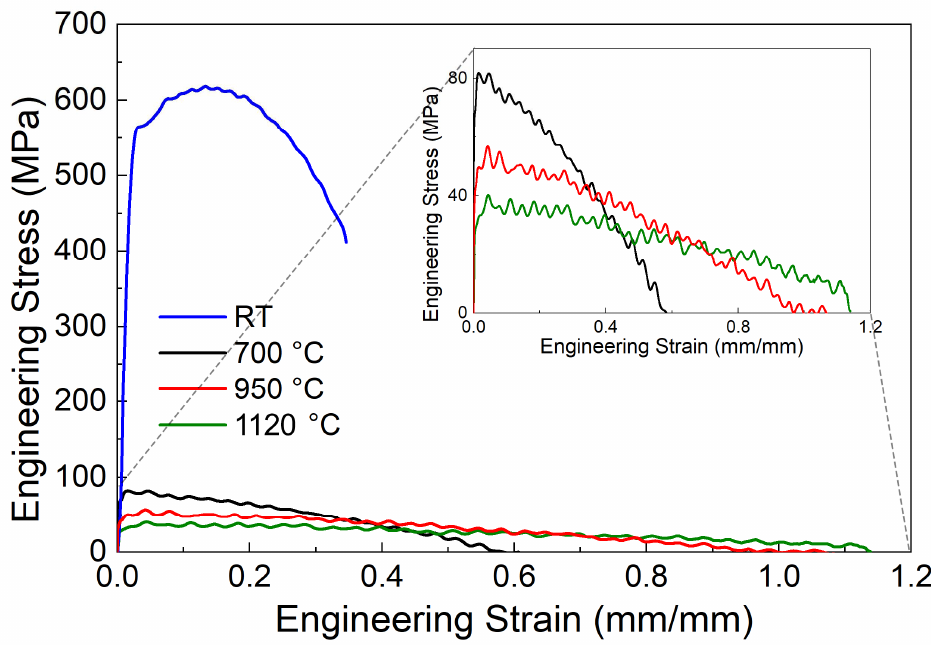
Figure 15. Engineering stress–strain plots for commercially pure titanium in tension at temperatures from room temperature up to 1120 °C and at strain rates from 1000 up to 1600 s −1 . The zoomed-in section shows the stress–strain plots at elevated temperatures in more detail.